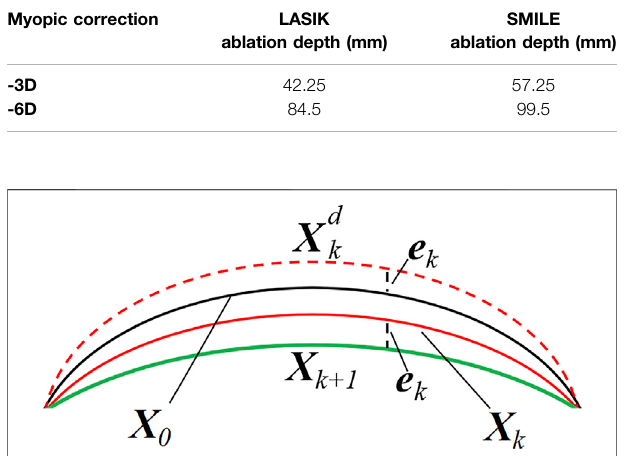
FIGURE 4 | Zero-pressure iterative